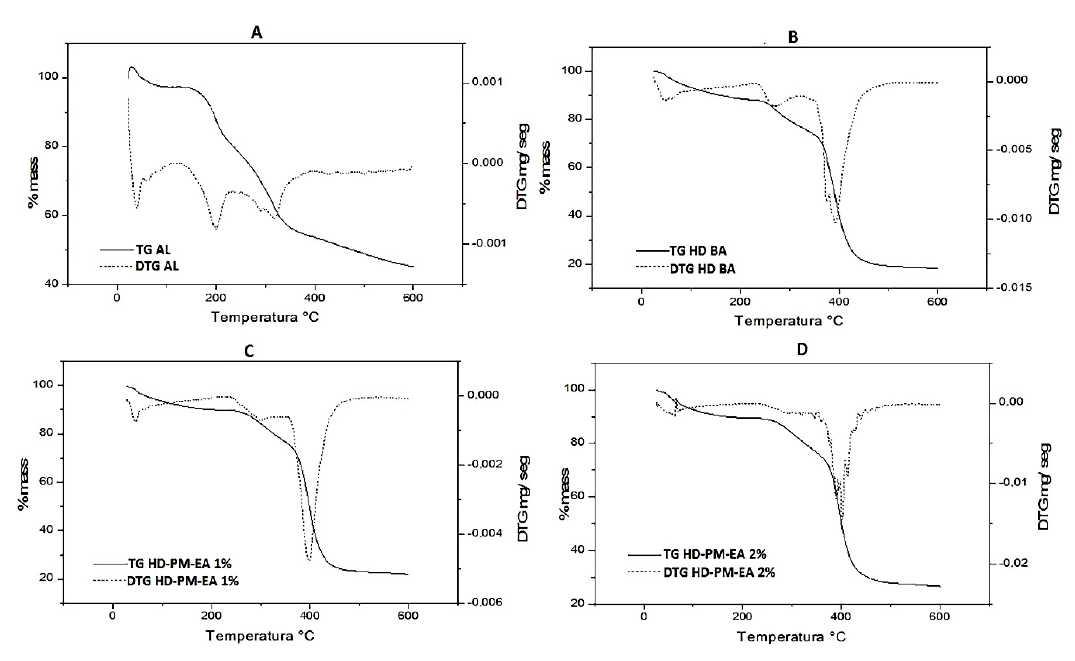
Figure 7. The thermograms of: ( A ) AL; ( B ) HD BA; ( C ) HD-PM-EA 1%; and ( D ) HD-PM-EA 2%.